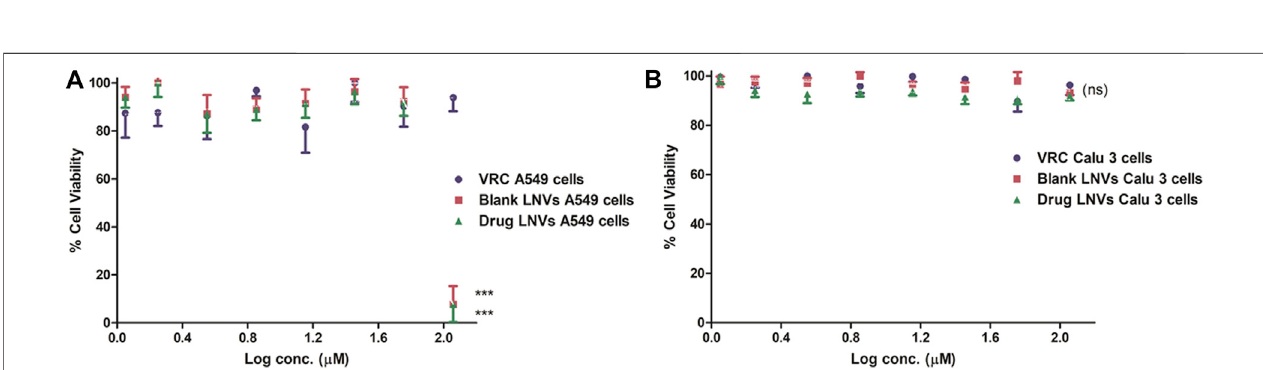
FIGURE6| CellviabilityassayemployingPrestoBlueonlungepithelialcelllines (A) A549and (B) Calu3celllinesforatime-durationof48 h.Datarepresentmean ± SD values ( n (cid:2) 3). The asterisks represent statistically signi fi cant difference (*** p < 0.0001) between the cell viability of drug compared to blank and drug-loaded formulation in A549 cells at log conc. of 2 μ M, while “ ns ” indicates an insigni fi cant ( p > 0.05) difference between the tested groups in Calu 3 cells (ns).